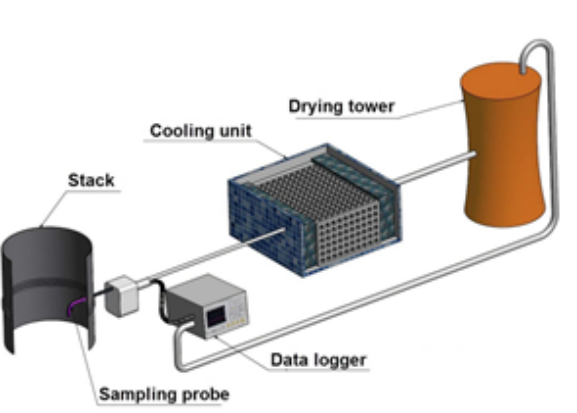
Figure 1. The measurement scheme for a flue gas analysis by gravimetric method.